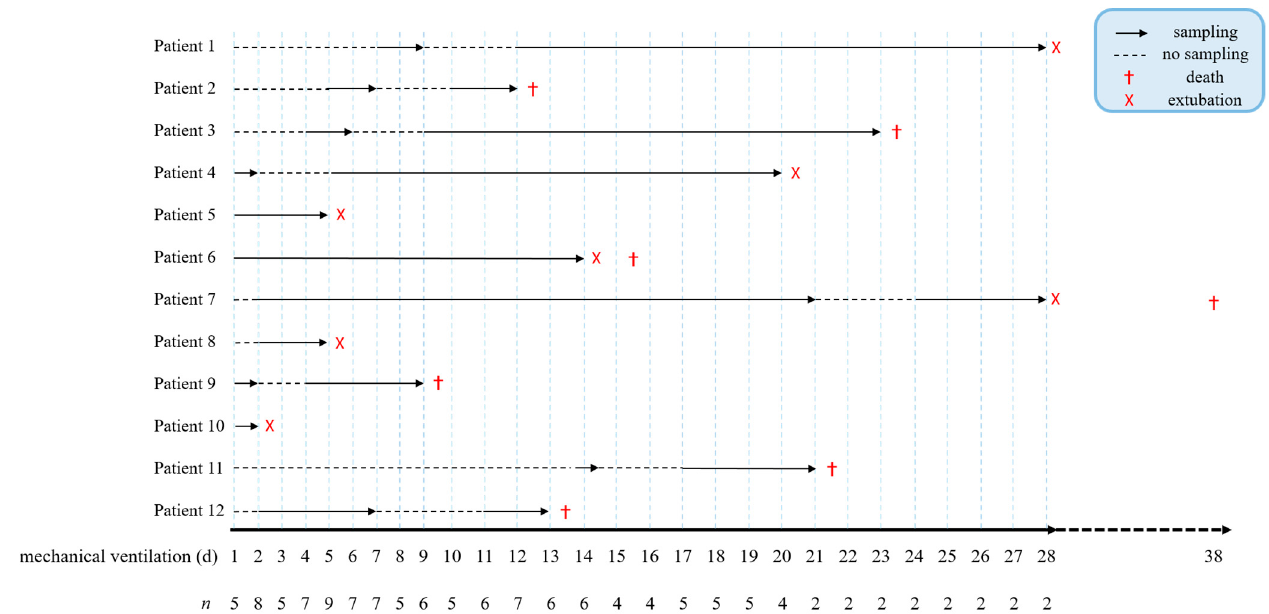
Figure 1. Sampling timeline of COVID-19 patients. Continuous sampling of serum and tracheal fluid began on the day that mechanical ventilation was required, and n refers to the number of patients from whom samples were received per day. Arrows indicate sampling, dotted lines represent sampling breaks, (X) marks patient extubation, and (†) the death of patients.